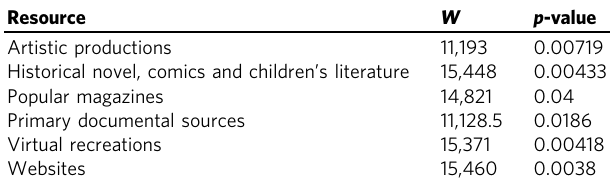
Table 5 Median and inference by education